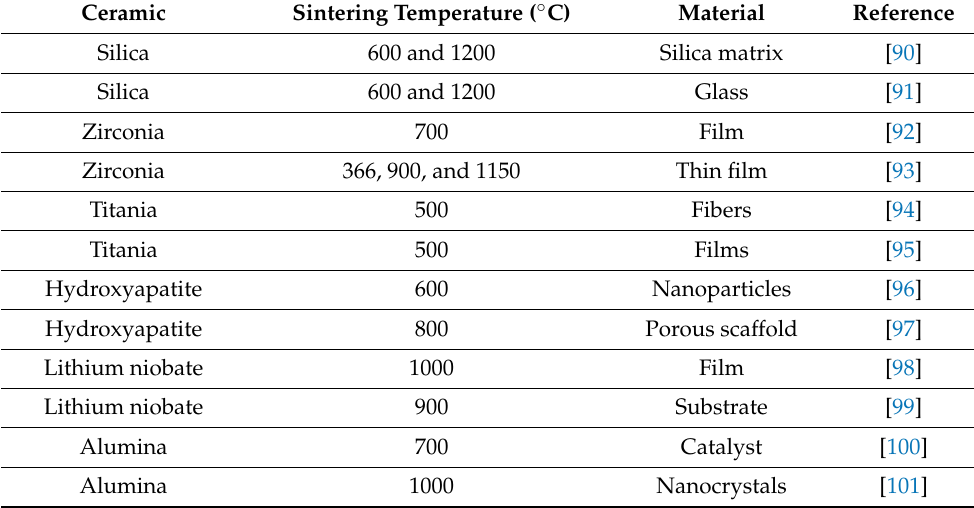
Table 2. Ceramics obtained by the sol–gel method and the temperatures used in their